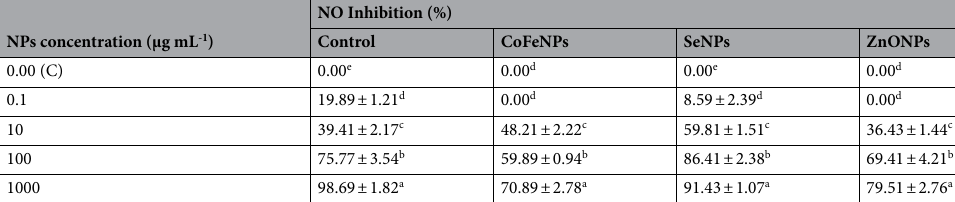
NPs concentration (µg mL -1